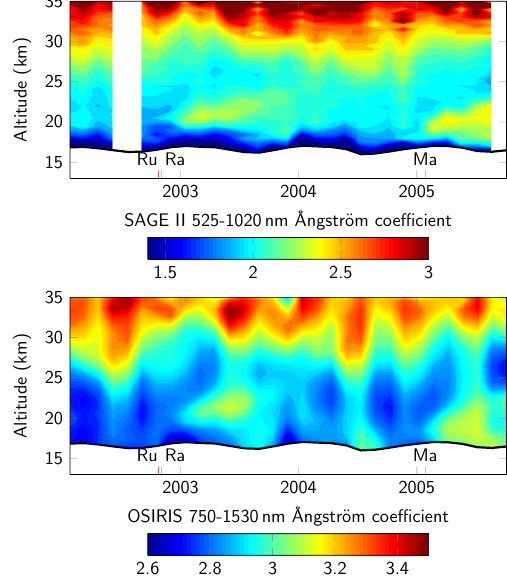
Fig. 16. Comparison of the OSIRIS and SAGE II ˚Angstr¨om coefficients as a function of mode radius, for a lognormal distribution with a mode width of 1.6